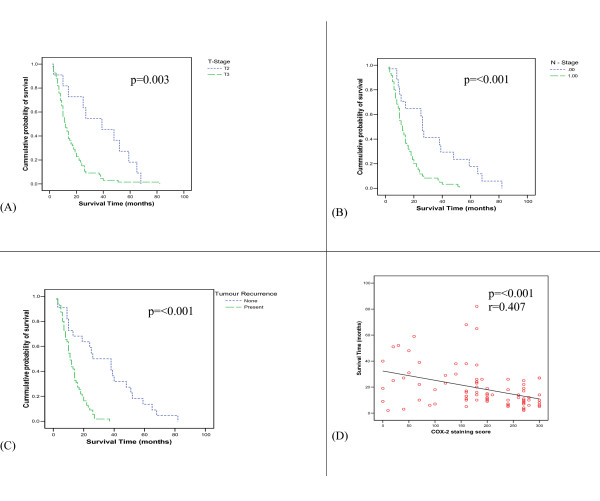
Correlation between survival and clinicopathologic parameters: Kaplan-Meier curves comparing survival with tumour invasion (A), nodal metastasis (B) and tumour recurrence (C). Linear regression (D) analysis showing negative correlation between survival and COX-2 expression.